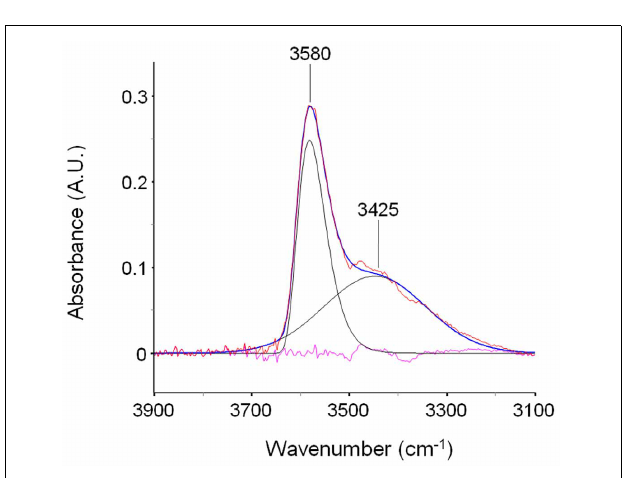
Figure 3 | LSCF analysis of the ν ( OH ) region (3900–3100cm − 1 ). The fitted spectrum is relative to a sample equilibrated in methanol vapor at p / p 0 = 0 . 3. The figure displays the experimental profile (red trace), the best-fitting result (blue trace), the two resolved components (black traces) and the residual (cyan trace, experimental—best-fit).